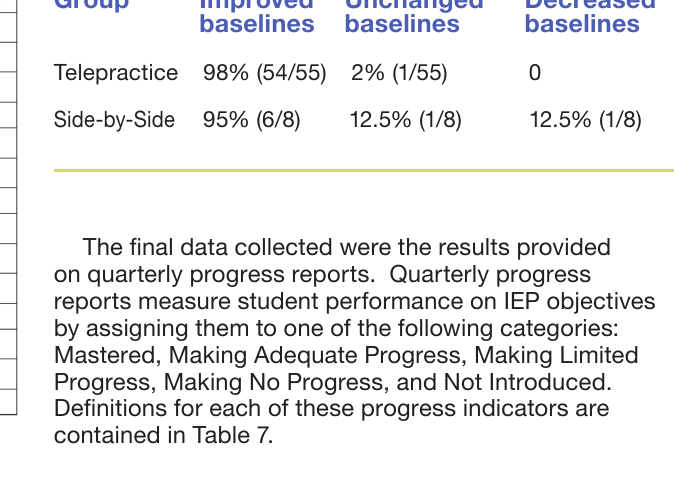
Table 7. Definitions of quarterly progress report